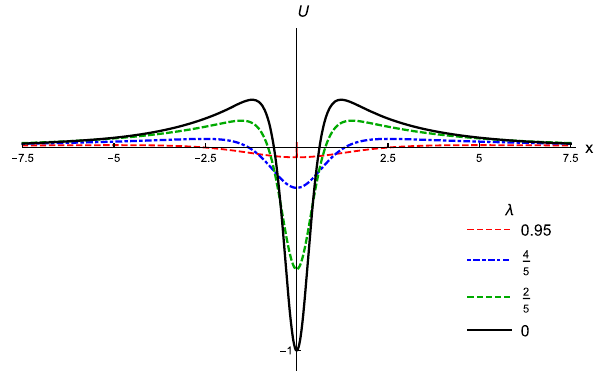
Fig. 12 The stability potential (58) for some values of λ . Here we observe that the stability potential of the gravitational sector consider- ably decreases when λ → 1, although it always maintains its volcano shape, implying stability for gravity localization. For λ = 1, Eq. (58)